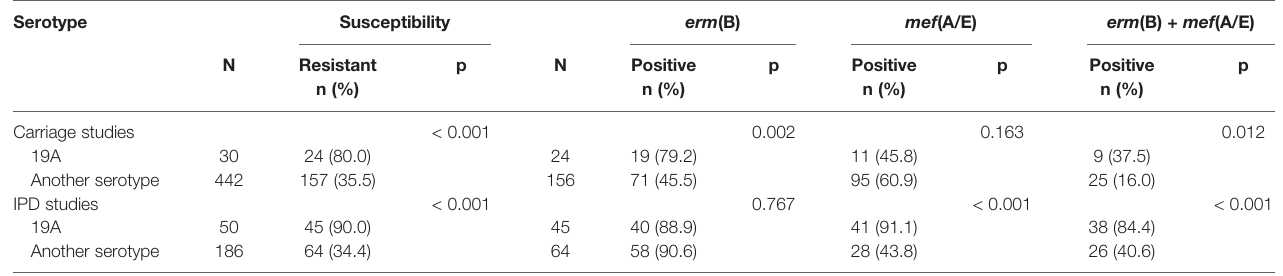
TABLE 4 | Macrolide resistance and genes among 19A pneumococcal isolates in carriage and IPD strains.